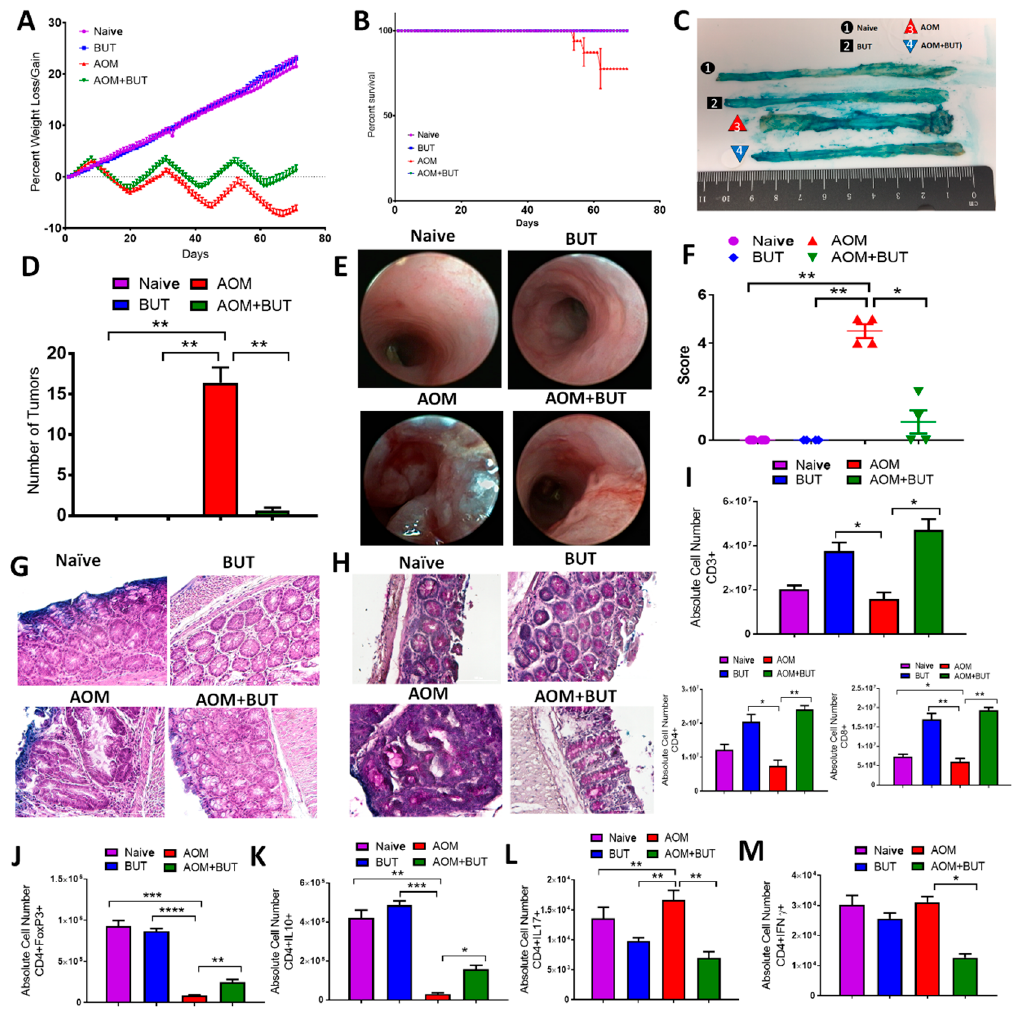
Figure 4. Treatment with sodium butyrate (BUT) reduces clinical symptoms and alters T cell phenotype in AOM-induced CRC model. Female C57BL/6 mice were injected intraperitoneal with 10 mg of AOM to induce colorectal cancer followed by 3 cycles of 2% DSS. Experimental groups consisted of: Naïve ( n = 4), BUT ( n = 4), AOM ( n = 4), and AOM + BUT ( n = 4). Clinical parameters consisted of percent weight loss ( A ) and survival ( B ), both of which were found to have significant differences in AOM vs. AOM + Resveratrol groups. ( C ) Representative colons stained with 1% Alcian blue. ( D ) Bar graph depicting number of tumors counted in each experimental group. ( E ) Representative colonoscopic images from experimental groups. ( F ) Bar graph depicting scores after examination of tumor polyps detected during colonoscopies. ( G ) Representative colon sections stained with H&E; scale bar = 100 µM at 40x objective. ( H ) Representative colon sections, which underwent PAS staining; scale bar = 100 µM at 40x objective. ( I ) Bar graphs depicting absolute cell numbers in MLN for general T cells (CD3+), T helper (CD3+CD4+), and cytotoxic (CD3+CD8+) T cells. ( J – M ) Bar graphs depicting absolute cell numbers in MLN for Tregs ( J ), Th cells producing IL-10 ( K ), Th17 ( L ), and Th1 ( M ) cells. Significance ( p -value: * p < 0.05, ** p < 0.01, *** p < 0.005, **** p < 0.001) was determined by using one-way ANOVA and post-hoc Tukey’s test for bar/dot graphs, Mann–Whitney test for weight data, and log rank test for survival curve. Data are representative of at least 3 independent experiments.